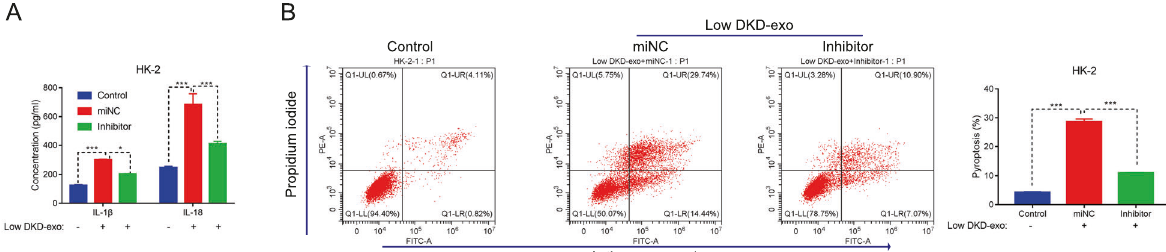
Fig. 5 Has-miR-4449 inhibitor disrupted the function of Low DKD-exo in the pyroptosis of HK-2 cells. A The has-miR-4449 inhibited suppression of the secretions of IL-1 β and IL-18 in HK-2 cells cultured with Low DKD-exo, *** P < 0.001. B The pyroptosis of HK-2 cells that were